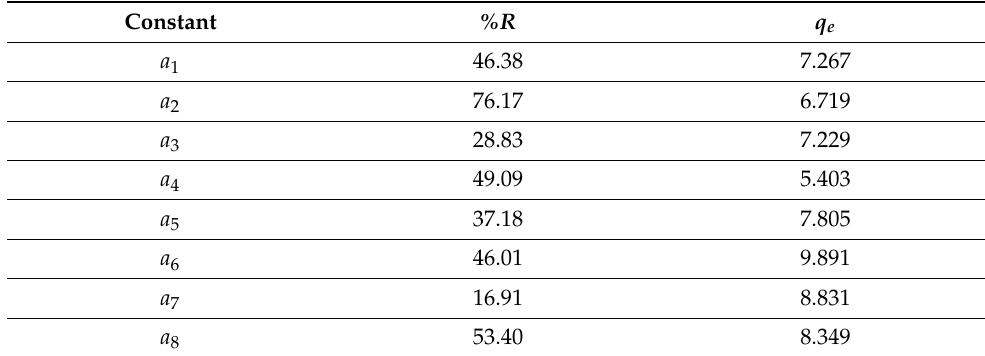
Table 4. Constants of the ANFIS model for the %R and q e fitting.